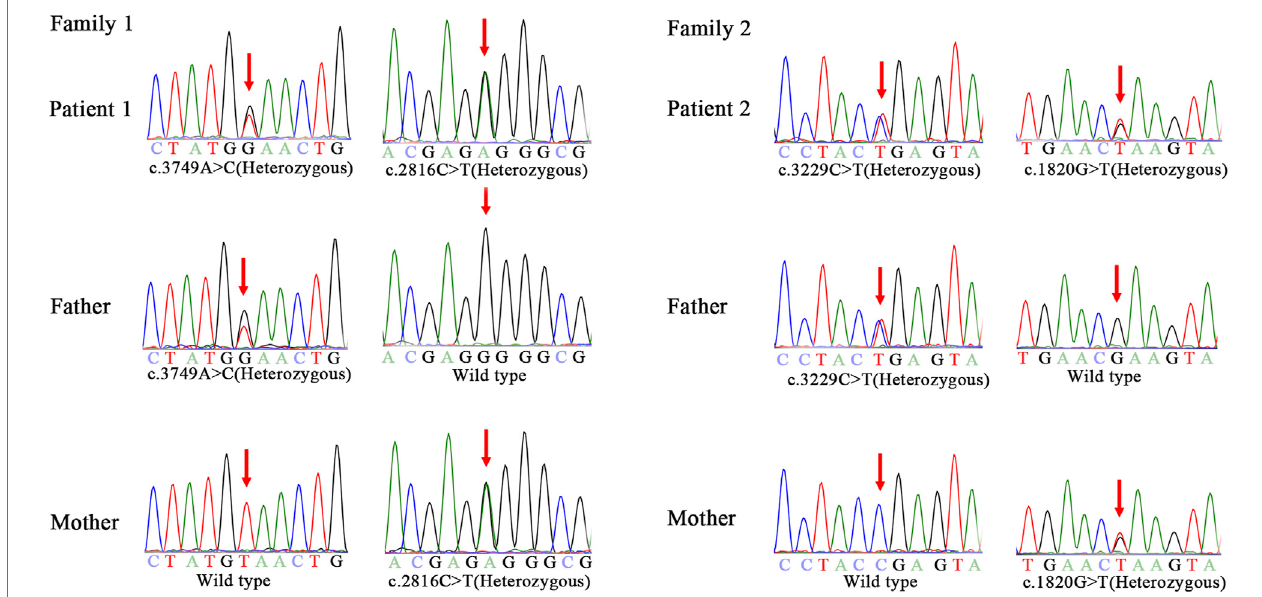
FIGURE 1 | Genotyping results on NPC1 by Sanger Sequencing analysis in the two families.